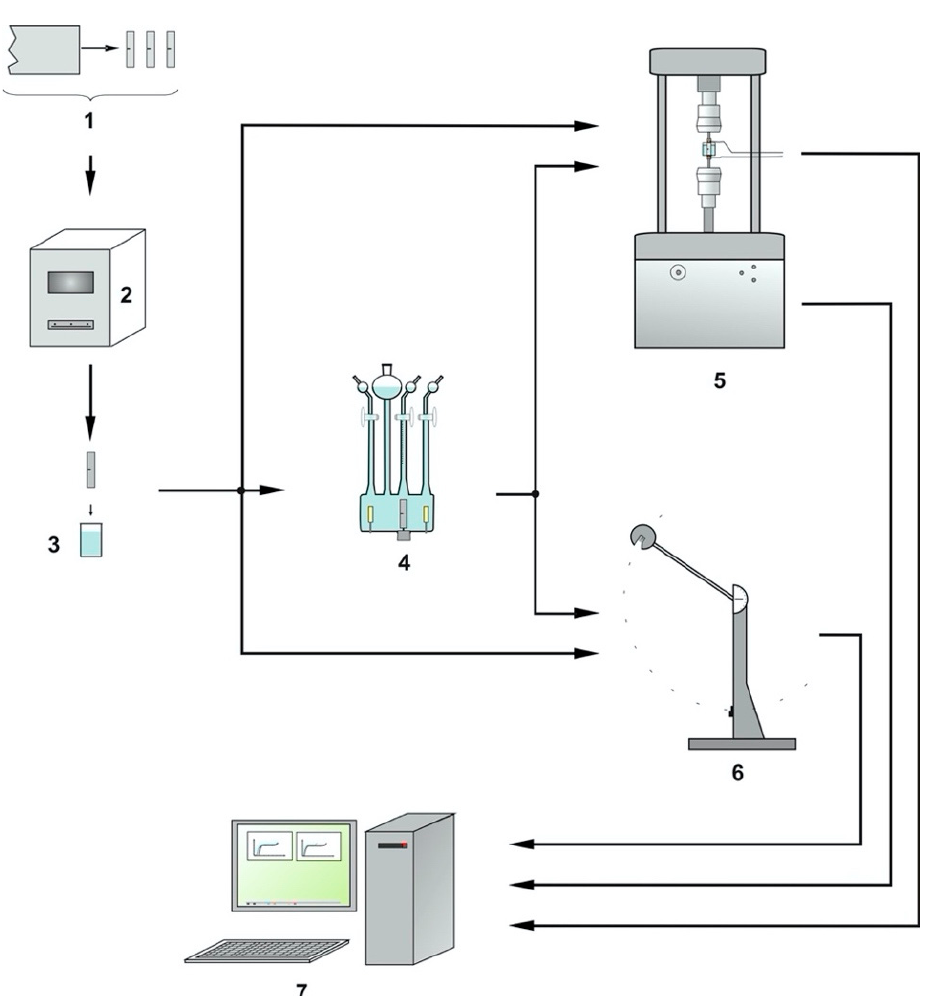
Figure 4. Preparation and experimental setups and schedule of measurements. 1—preparation of alloy specimens, 2—annealing in a muffle furnace, 3—degreasing alloy specimens, 4—Hoffman apparatus, 5—universal testing machine, 6—Charpy hammer, and 7—computer.